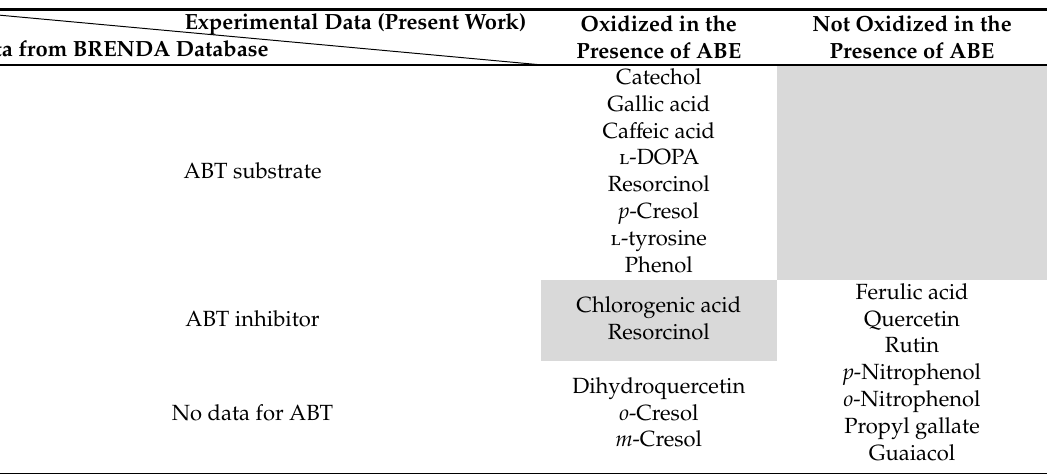
Not Oxidized in the Presence of ABE Presence of ABE Catechol Gallic acid Ca ff eic acid l -DOPA Resorcinol p -Cresol l -tyrosine Phenol Ferulic acid Chlorogenic acid Quercetin Resorcinol Rutin p -Nitrophenol Dihydroquercetin o -Nitrophenol o -Cresol Propyl gallate m -Cresol